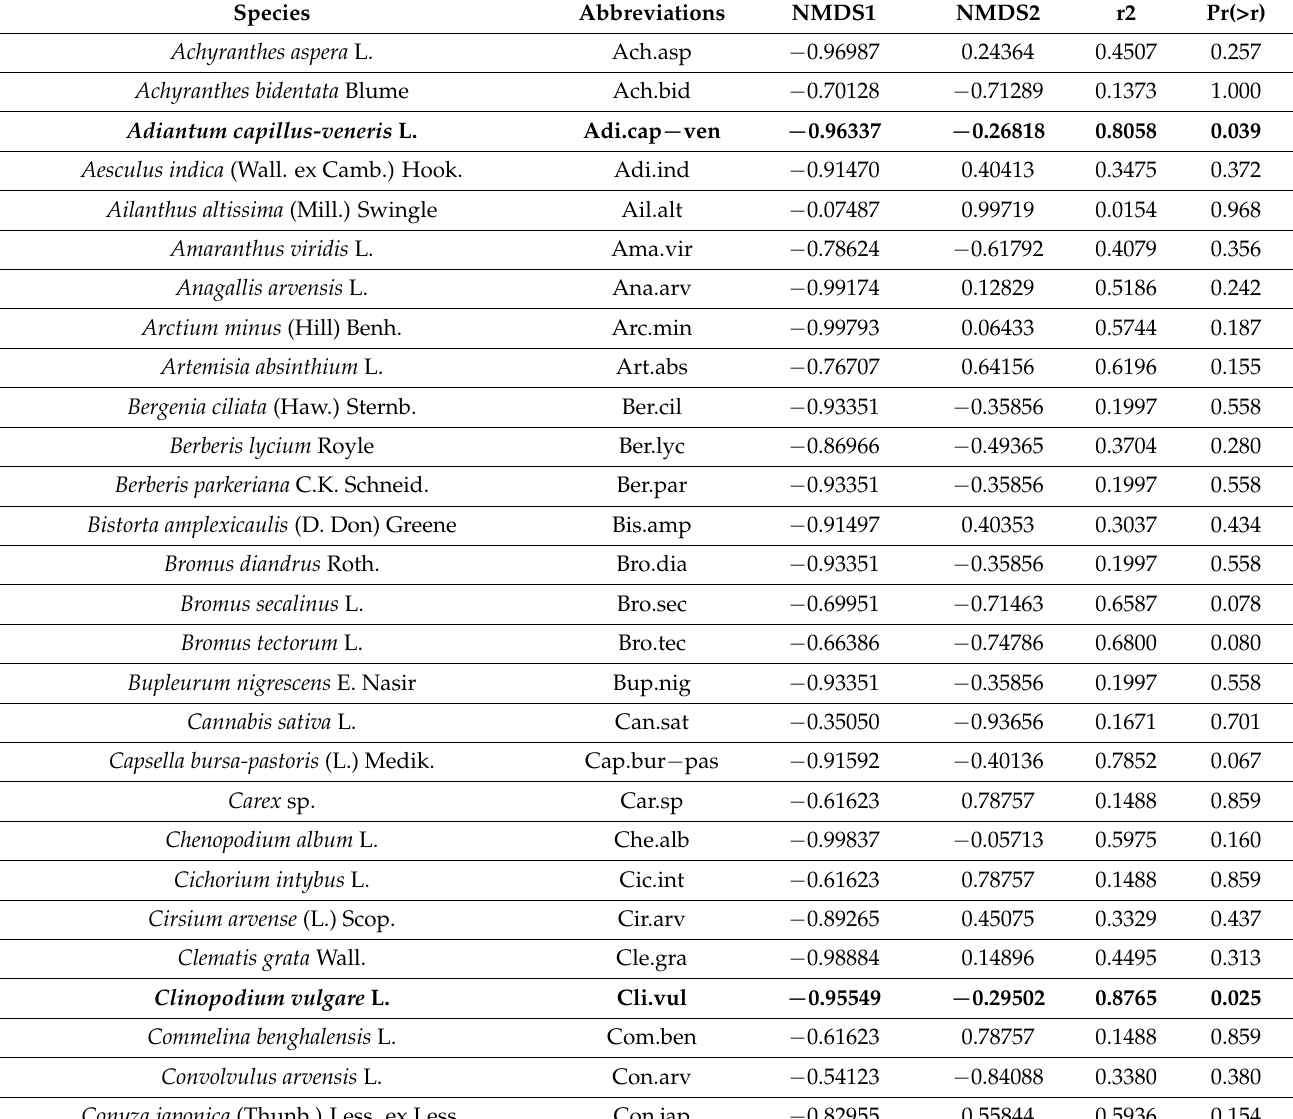
Table 1. Species contribution analysis for the site distribution pattern, referred to as intrinsic variables. Significant species are displayed in